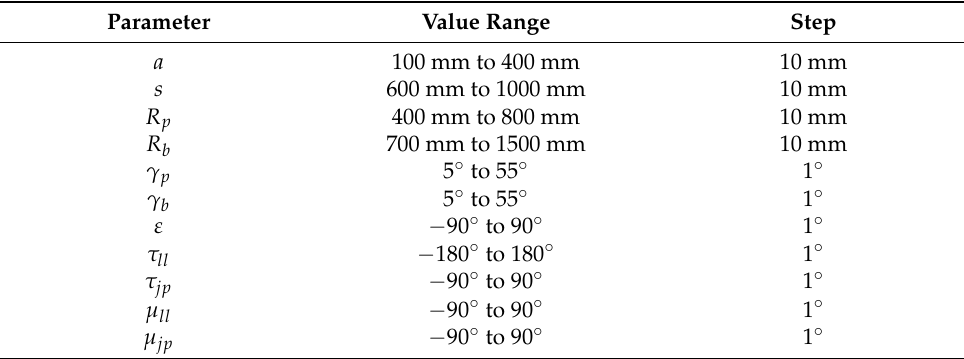
Table 2. Value range of geometric parameters for